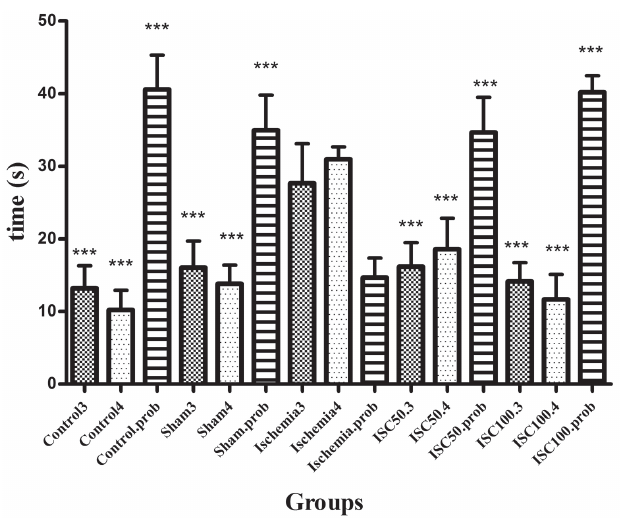
FIGURE 1 - The effect of A. italica extract on learning and spatial memory in Morris water maze test on hippocampal injury induced by transient global cerebral ischemia and reperfusion. time: latency to find the platform on day 3, 4 and duration of swimming in target zone on the probe day. ISC 100 and ISC 50: treated with 100 and 50 mg/kg of Anchusa italica extract, respectively. (***: significant difference between the all groups with ischemia group, <0.001). The number of samples, n=7.